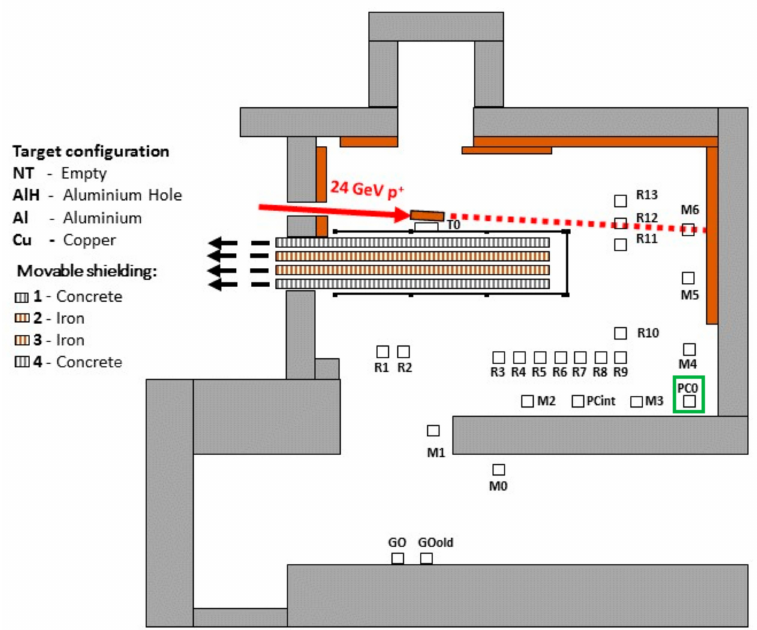
Figure 2. Layout of the irradiation area at CERN High Energy Accelerator Mixed-Field Facility (CHARM) test facility [6].